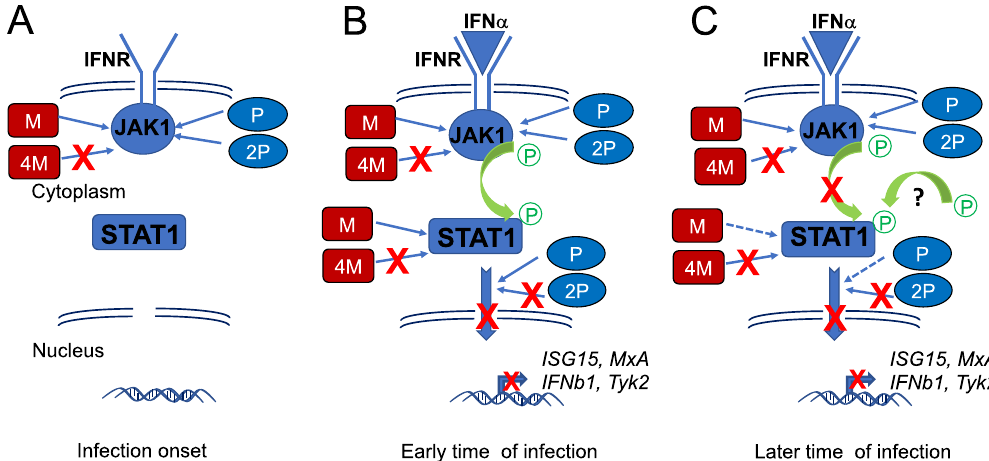
Figure 7. Model of the cooperation between M and P proteins to inhibit different Jak-Stat-pathway steps. ( A ) At infection onset, before the IFN response is triggered and IFN α binds to its receptor (IFNR), JAK1 and STAT1 are not phosphorylated. Then, both RABV M (red) and P (purple) proteins can interact with JAK1, although M-STAT is favoured. Only the mutant 2P (pink) but not 4M (orange) interact with JAK1 (phosphorylated or not). ( B ) In the presence of IFN α , JAK1 is phosphorylated which lead to the phosphorylation of STAT1 and translocation in the nucleus of STAT phosphorylated dimers and finally activation of ISRE promotors and increase of transcription of corresponding genes (ex: ISG15, MxA, IFN β 1 and Tyk2). This is inhibited in the context of a RABV infection by both M and P proteins. Neither the mutant 2P nor 4M are able to interact with STAT1 (phosphorylated or not). Less than 30 min after IFN stimulation (1), the M protein blocked JAK1 phosphorylation and then STAT1 phosphorylation. 30 min after the initial stimulation (2), P destabilises M-JAK1 and the M protein switches towards pSTAT1 interaction, which then enhances the capacity of P protein to also switch towards pSTAT1 interaction and inhibit the translocation of phosphorylated STAT dimers. ( C ) Several hours later, P and M proteins tend to interact preferentially with JAK1, although the initially high P/ JAK1 levels were never again